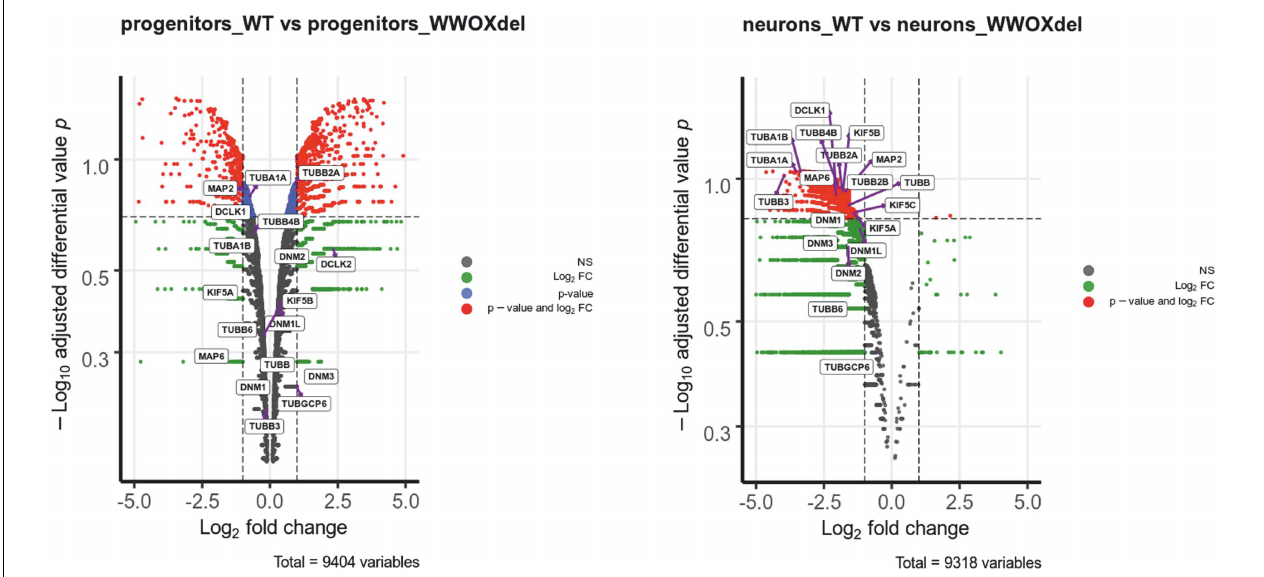
FIGURE 4 | Wwox-depleted neurons show reduced expression of different neural migration-related genes. The differential gene expression profiles in control hNPC vs. WWOX-depleted hNPC and control neurons vs. WWOX-depleted neurons represented in Volcano Plot. P – significance was calculated according to NOISeq-sim